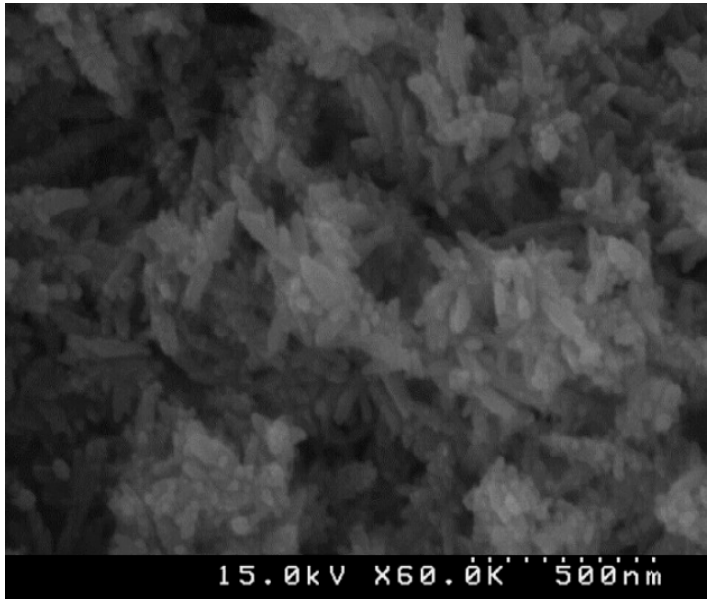
Figure 4. SEM photographs of [Pb(L)Br 2 ] n ( 1 ) nanorods.